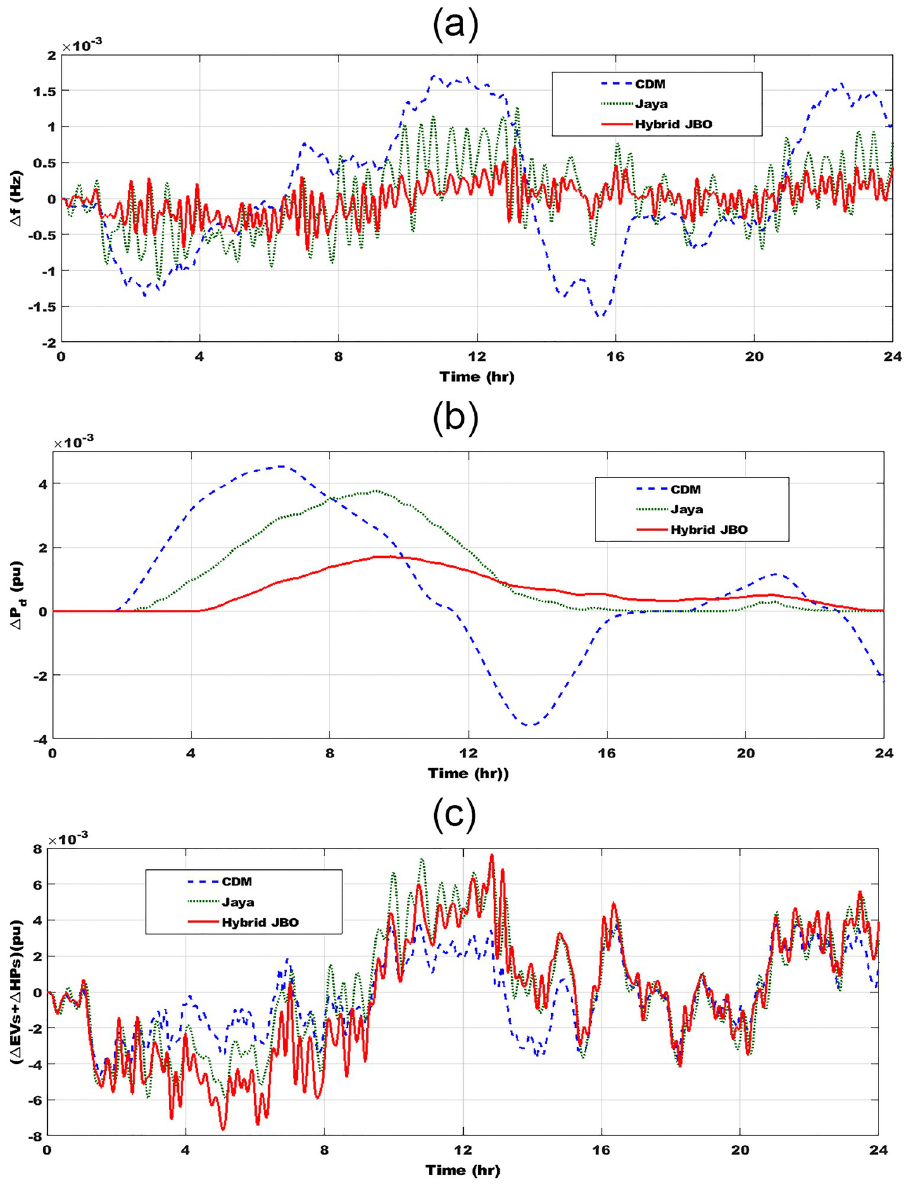
Fig 11. System dynamic response in the first scenario: (a) frequency deviations; (b) deviation of diesel generator power change; (c) deviation of EVs and HPs power change.